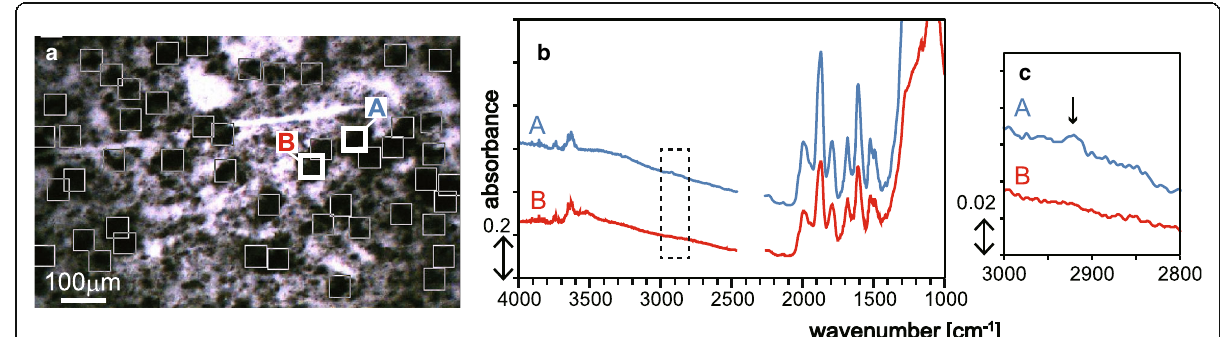
Fig. 3 An example of the optical photomicrographs and transmission IR spectra of the analyzed carbonaceous clots. a Optical photomicrograph. The squares indicate the analyzed areas (50 × 50 μ m 2 ). The IR spectra of the two analyzed areas (thick-bordered squares A and B) are shown in b and c . b Transmission IR spectra (64 scans) of the carbonaceous clots with ( a ) and without ( b ) aliphatic CH moieties. One scale unit on the vertical axis corresponds to an absorbance of 0.2. The IR spectrum in b is representative of those obtained from the white squares in a (without aliphatic CH bonds). c An enlarged view of the IR spectra in b within 3000 – 2800 cm − 1 . The range is indicated by the dotted rectangle in b . The arrow represents the IR band at ~ 2925 cm − 1 . One scale unit on the vertical axis corresponds to an absorbance of